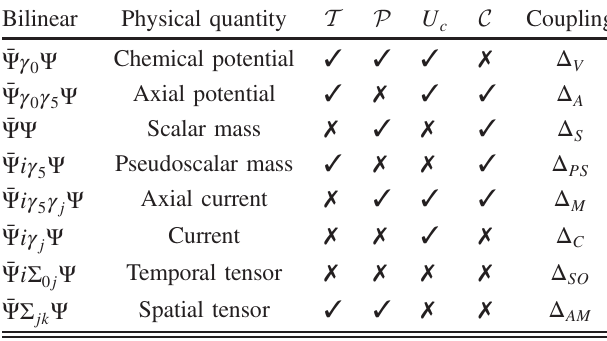
TABLE III. Various types of disorder represented by fermionic bilinears ( j ¼ 1 , 2, 3), together with their symmetries under pseudo-time-reversal ( T ), parity ( P ), continuous chiral rotation ( U ), and charge conjugation ( C ). The disorder couplings are c represented by Δ and Σ μν ¼ ½ γ μ ; γ ν (cid:3) = ð 2 i Þ . Note that true time- N reversal symmetry in WSM is already broken. The pseudo-time- reversal symmetry T is generated by an antiunitary operator